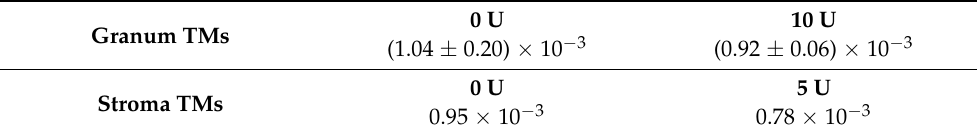
Table 2. Initial amplitudes of the gramicidin-sensitive, electrochromic absorbance transients (ECS) of granum and stroma thylakoid membranes treated with 0 and 10 U, and 0 and 5 U wheat germ lipase, respectively. The ECS transients were measured at 520 nm. Mean values and standard deviations for the granum TMs were obtained from three batches; one batch of stroma TMs was used. Granum